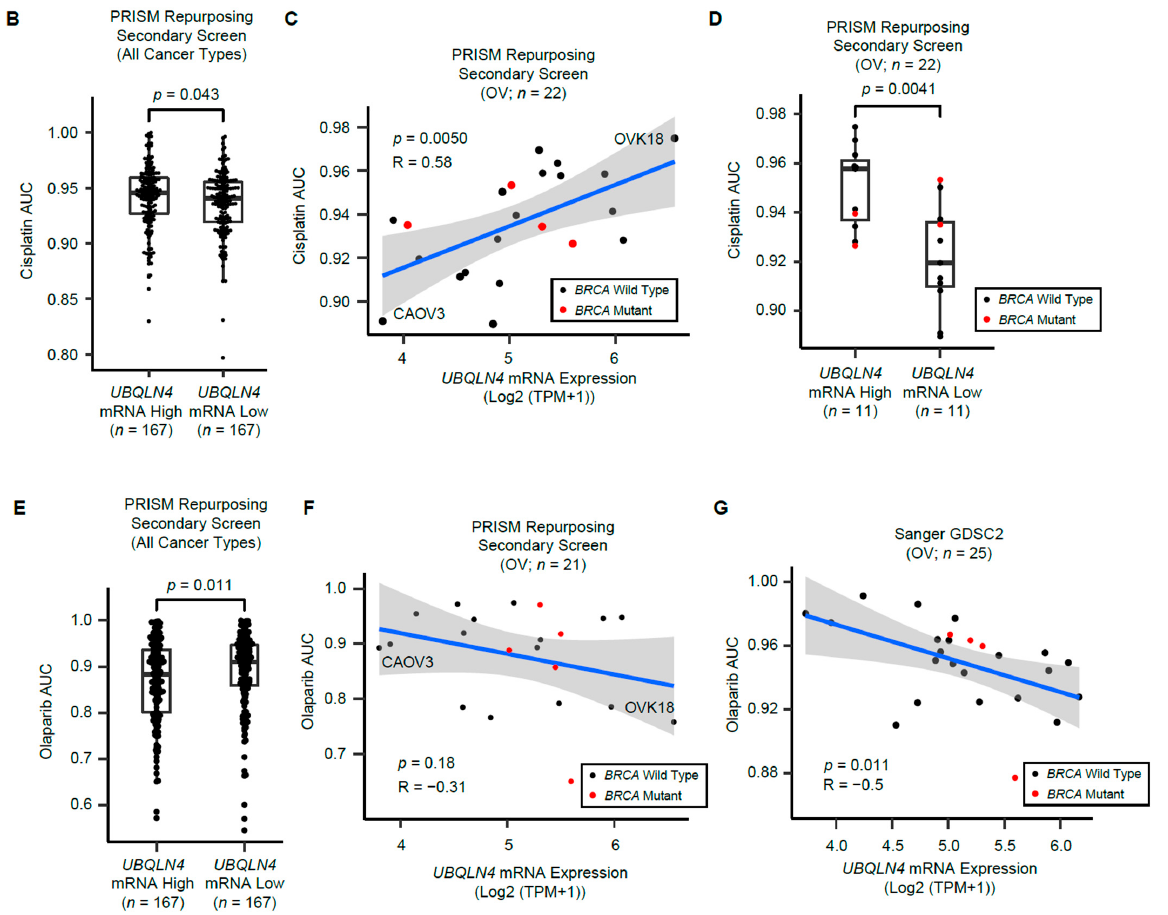
Figure 4. High UBQLN4 mRNA levels are associated with cisplatin and Olaparib responses. ( A ) All cell lines from CCLE dataset were divided according to the median UBQLN4 mRNA levels and gene set enrichment analysis (GSEA) was performed to compare the difference between the two groups. (Right) Bar plot showing the six significantly enriched gene sets in high UBQLN4 mRNA group. The x-axis indicated the minus logarithm of FDR values of each gene set. (Left) Comparison of the normalized enrichment score for the DNA repair pathway determined by GSEA. FDR, false discovery rate; NES, normalized enrichment score. ( B ) Comparison of cisplatin area under curve (AUC) values in low UBQLN4 expression cell lines and high UBQLN4 expression cell lines in all cancer types in PRISM Repurposing Secondary Screen datasets. Statistical difference was evaluated using the Mann–Whitney U test. ( C ) Pearson’s Correlation between UBQLN4 mRNA levels and cisplatin AUC values in ovarian cancer (OV) cell lines in PRISM Repurposing Secondary Screen datasets. The red dots indicated the cell lines containing BRCA1 or/and BRCA2 mutations. ( D ) Comparison of cisplatin AUC values in ovarian cancer (OV) cell lines with low and high UBQLN4 mRNA levels in PRISM Repurposing Secondary Screen datasets. The red dots indicated the cell lines containing BRCA1 or/and BRCA2 mutations. Statistical difference was evaluated using the Mann–Whitney U test. ( E ) Comparison of Olaparib AUC values in low and high UBQLN4 mRNA in all cancer types in PRISM Repurposing Secondary Screen datasets. Statistical difference was evaluated using the Mann–Whitney U test. ( F ) Pearson’s correlation between UBQLN4 mRNA expression and Olaparib AUC values in OV cell lines in PRISM Repurposing Secondary Screen datasets. The red dots indicated the cell lines containing BRCA1 or/and BRCA2 mutations. ( G ) Comparison of Olaparib AUC values in low and high UBQLN4 mRNA levels cell lines in OV in Sanger GDSC2 datasets. The red dots indicated the cell lines containing BRCA1 or/and BRCA2 mutations. Statistical difference was evaluated using the Mann–Whitney U